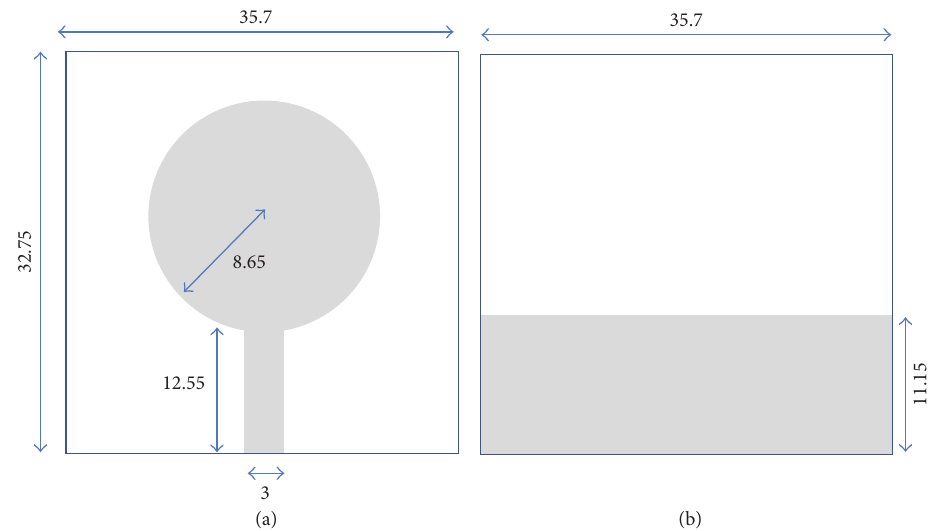
Figure 3: The circular planar monopole UWB antenna geometry. (a) Top view. (b) Bottom view [all dimensions are in mm].